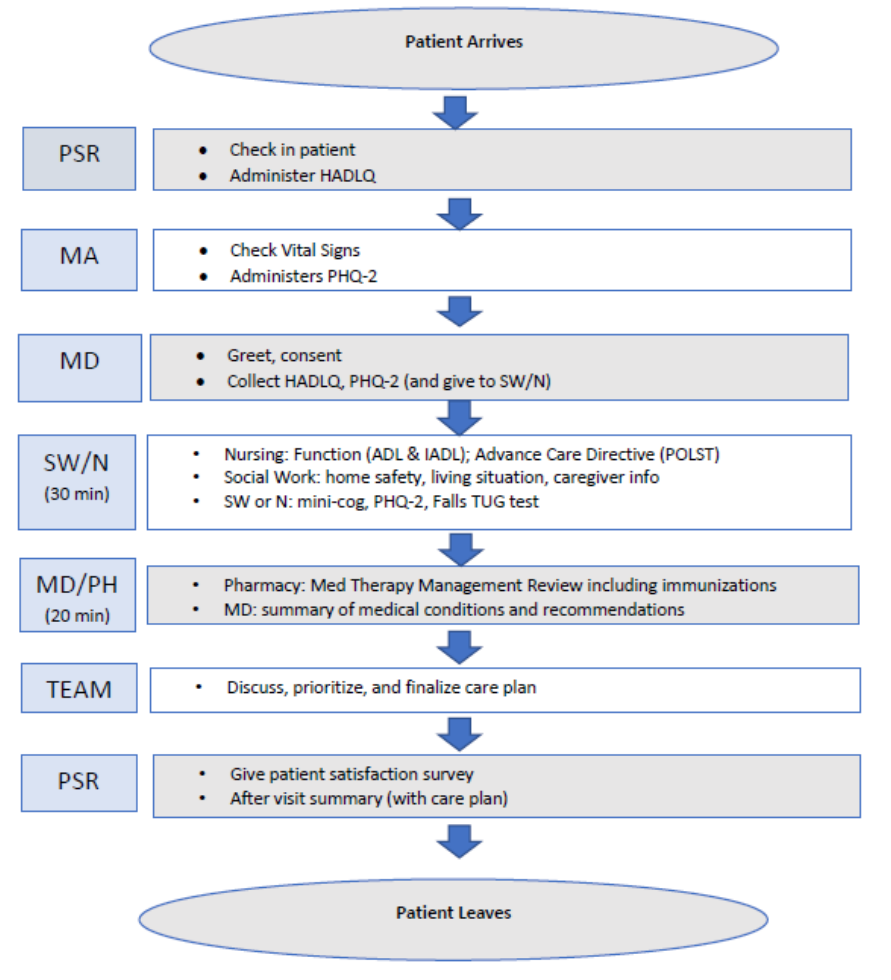
Figure 1. Annual wellness visit clinic workflow.